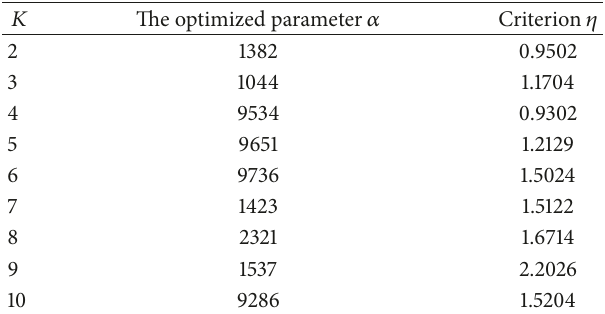
Table1:Theoptimizedparameter 𝛼 ofeach K